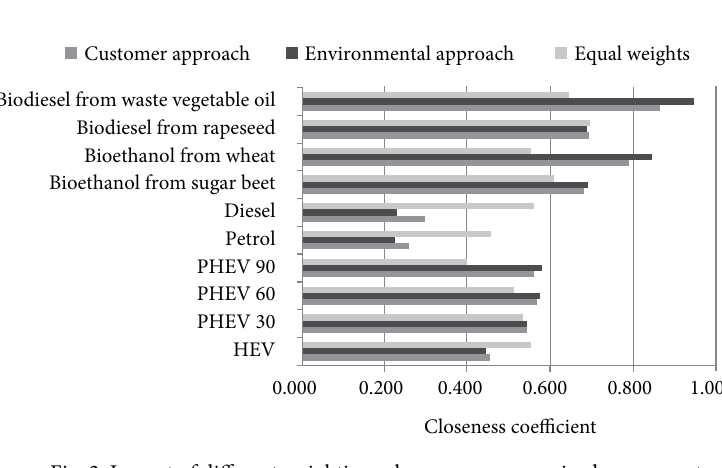
Fig. 2. Impact of different weighting schemes on summarized assessment of energy